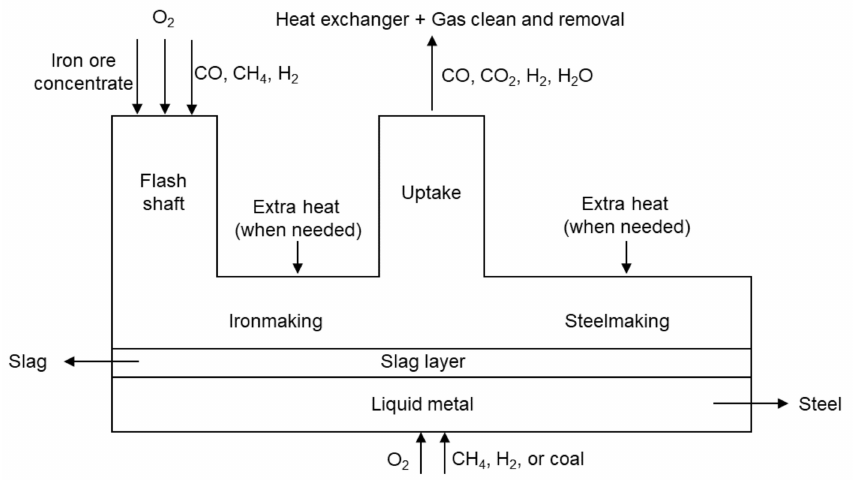
Figure 1. The schematic diagram of the flash ironmaking technology and its potential for the steelmaking